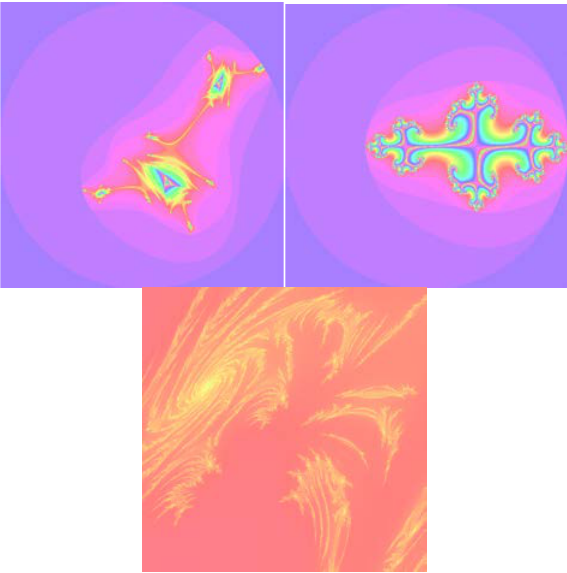
Fig.2. Examples of diagrams for general case of different parameters a and b. From left to right: a=- 0,75, b=1,6, x=0,74, y=0,97; a=1,14, b=1,39, x=0,28, y=0,01; a=- 0,6, b=0,3, x=- 0,7,